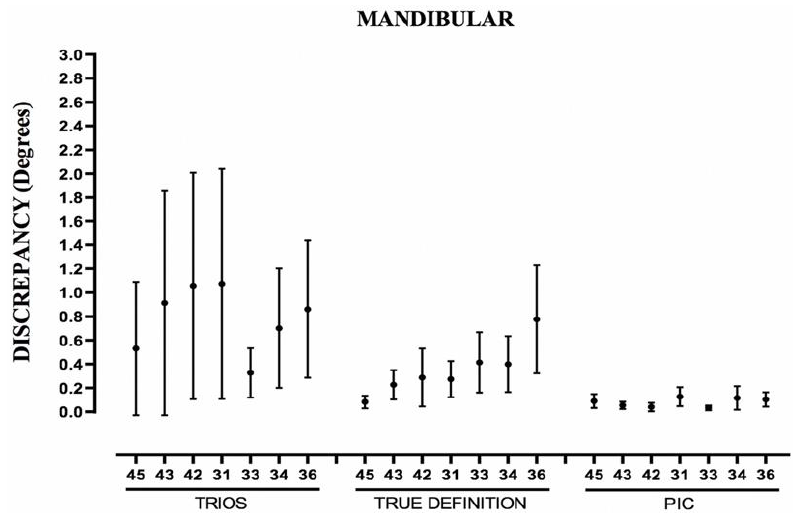
Figure 7. Boxplot showing measurements of relative angulations of abutments of maxillary arch. Abutment 26 is used as reference. Point represents mean error; line represents standard deviation.